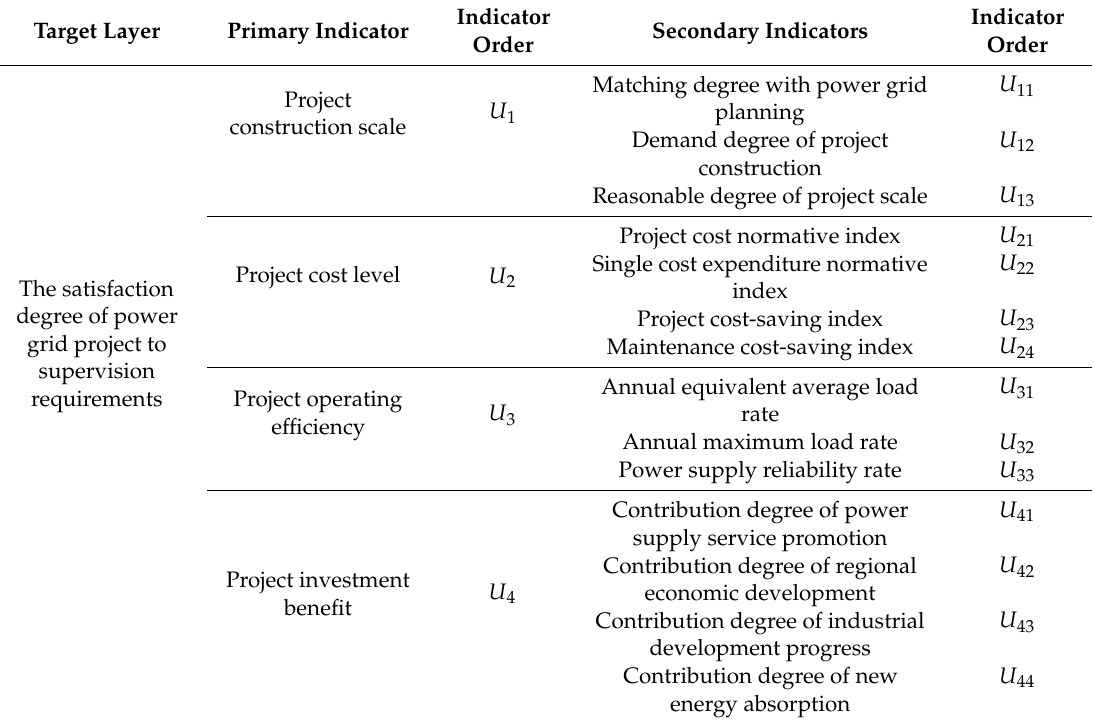
Table 1. Power grid investment behavior (PGIB) compliance evaluation index